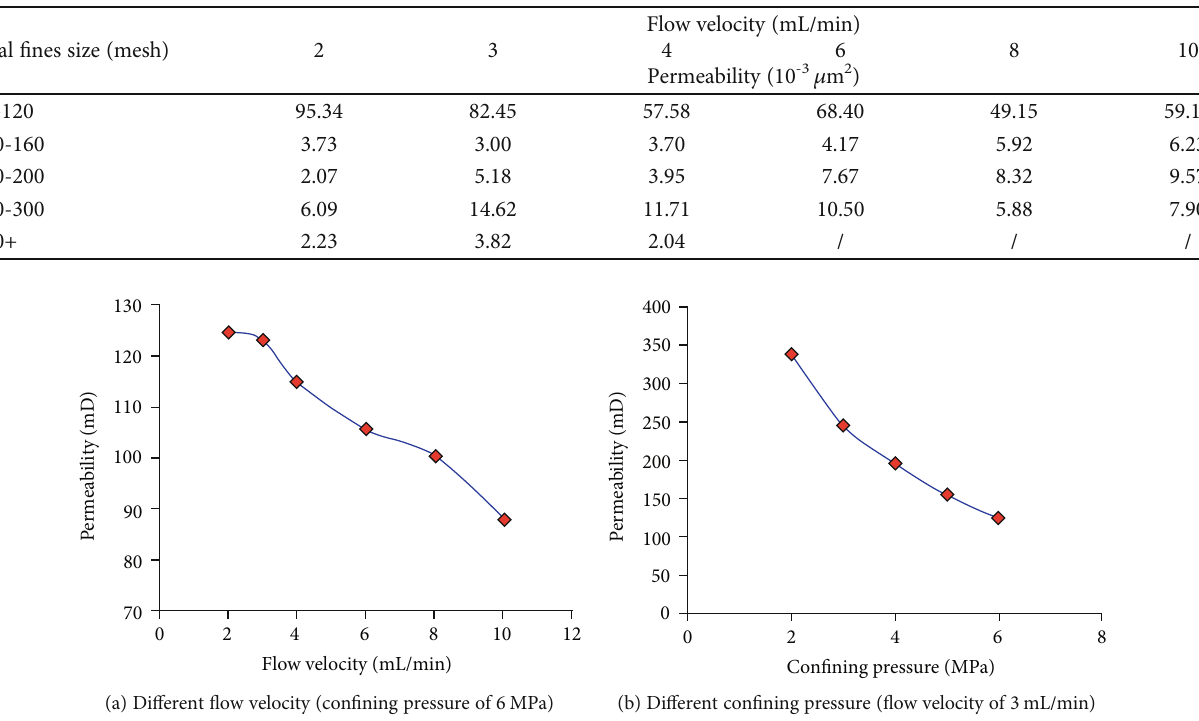
Table 3: Permeability of coal fi nes intrusion at di ff erent fl ow velocities.